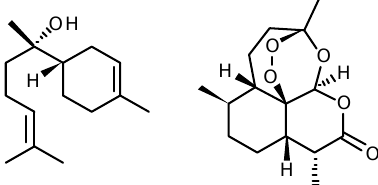
Figure 2. ( − )-alpha-Bisabolol ( left ) and artemisinin ( right